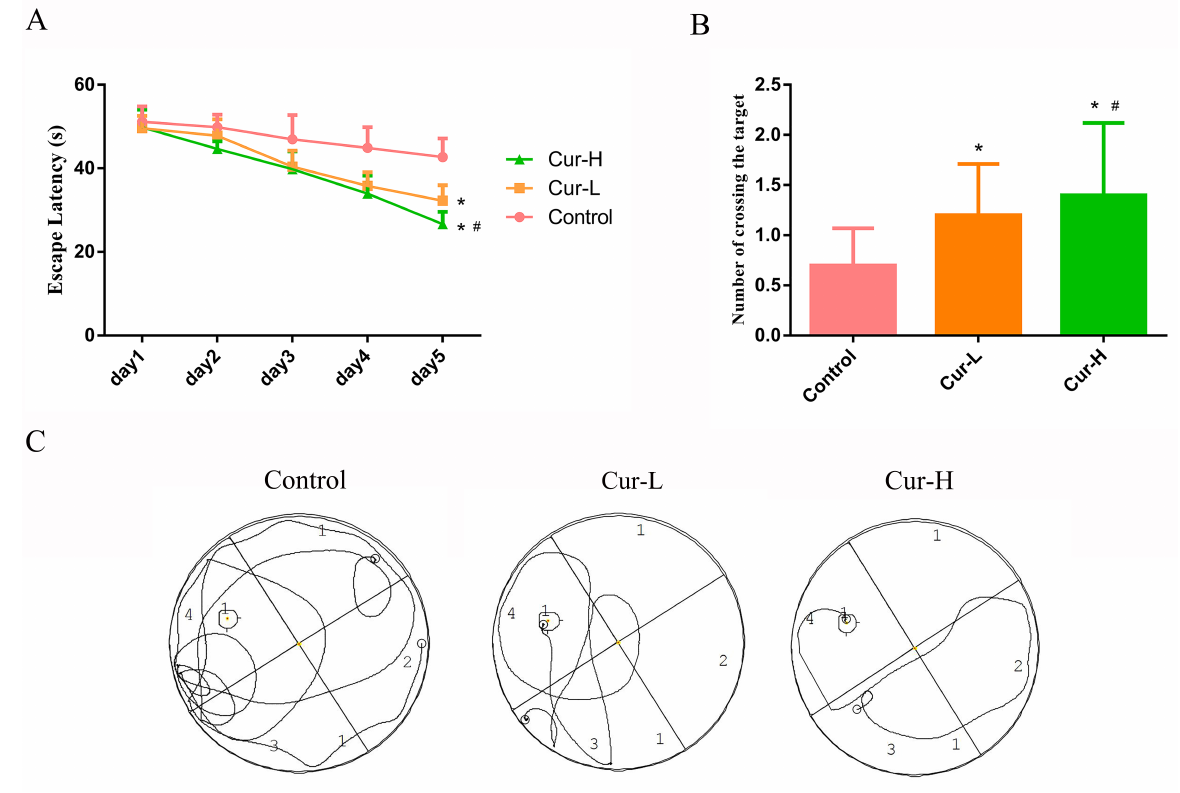
Fig. 1. Curcumin improved cognitive function of APP/PS1 double transgenic mice. (A) The escape latency during the 5-day MWM testes. (B) The number of crossing the target on the last day of the MWM test (n = 5, two-way repeated-measures ANOVA, Tukey’s test, # p < 0.05, versus Cur-L; * p < 0.01, versus Control). (C) The representative route track map for every group to